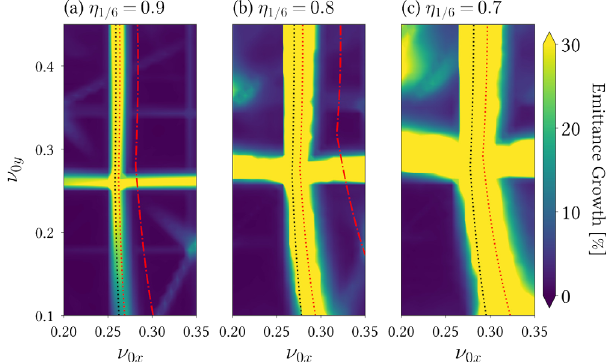
FIG. 7. Beam-intensity dependence of the stop band near ν 0 x ¼ 1 = 4 obtained from 2D W ARP simulations under the equipartition- ing condition. Similarly to the examples in Fig. 5, we have considered the three different beam intensities corresponding to (a) η 1 = 6 ¼ 0 . 9 , (b) η 1 = 6 ¼ 0 . 8 , and (c) η 1 = 6 ¼ 0 . 7 . The definitions of the red and black dotted lines are the same as in Fig. 5.